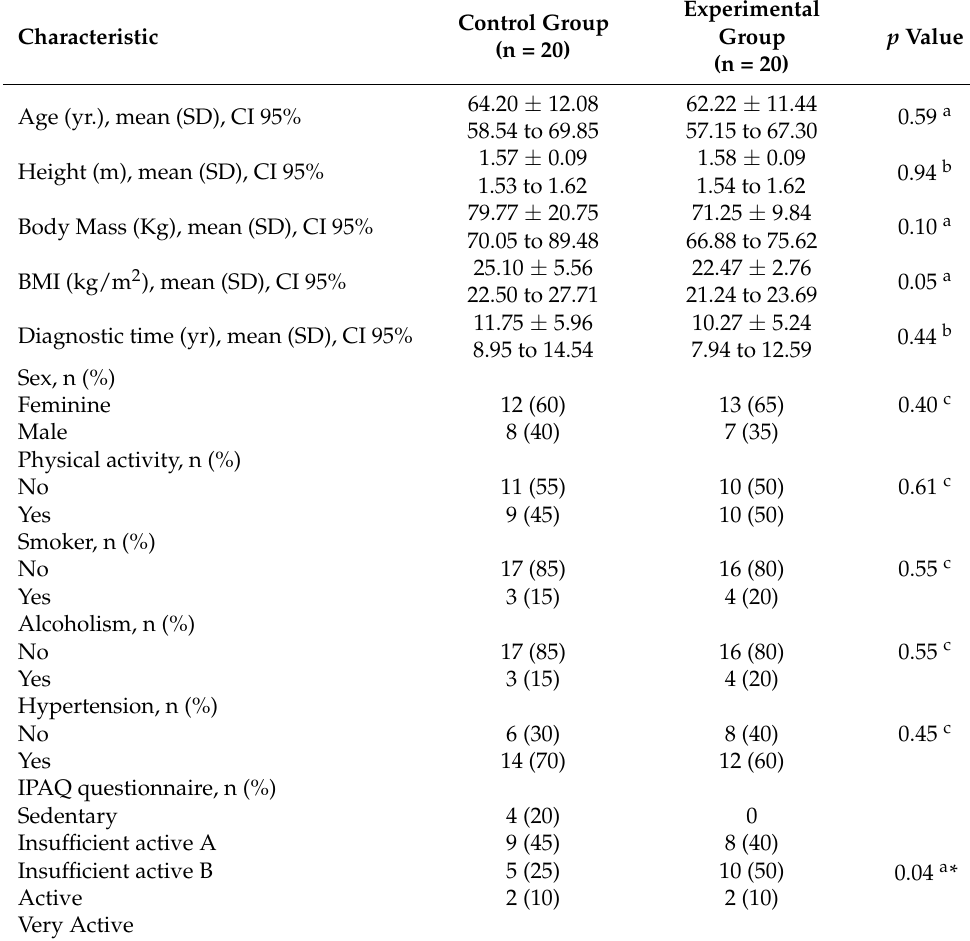
Table 1. Demographic characteristics of participants: control and experimental groups.